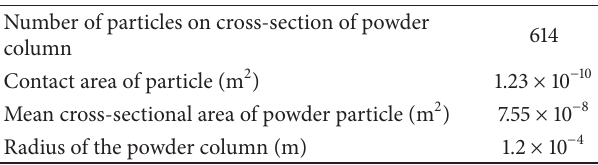
significantly greater than the melting temperature of Ti 5 Si 3 . Table 4: Geometric parameters in the pinch pressure